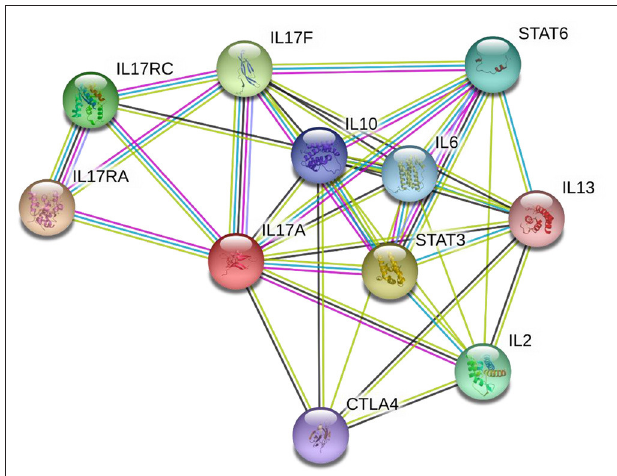
FIGURE 2 | STRING diagram illustrating the known and predicted protein interactions for IL-17A. Network nodes represent proteins—each node represents all the proteins produced by a single, protein-coding gene locus. Edges (lines) represent protein-protein associations that are specific and meaningful, i.e., proteins jointly contribute to a shared function; this does not necessarily mean they are physically binding each other. Blue connecting lines indicate that protein interaction information was derived from curated databases, pink indicates the interaction was experimentally determined, yellow indicates the interaction was determined via text mining, black indicates protein co-expression, and lilac indicates protein homology. Analysis was performed on 28 July 2021 via the string-db.org